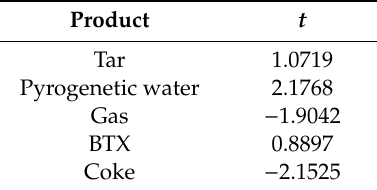
Table 5. Values of Student’s t statistics.